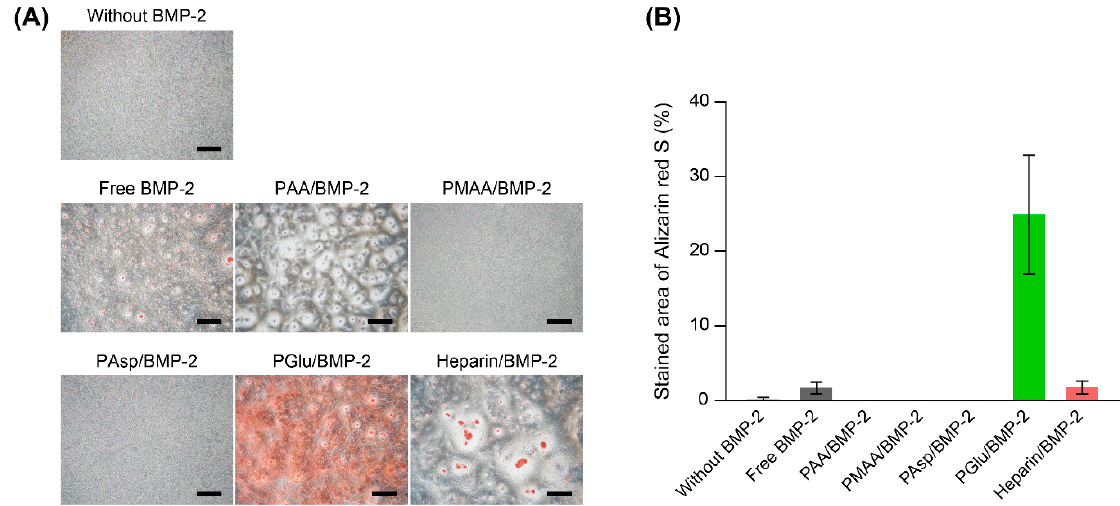
Figure 6. ( A ) Alizarin red S staining of MC3T3-E1 cells treated with free BMP-2, PAA / BMP-2, PMAA / BMP-2, PAsp / BMP-2, PGlu / BMP-2, and heparin / BMP-2 complexes for 14 d (Scale bars: 500 µ m). ( B ) Relative area of MC3T3-E1 cells stained with Alizarin red S (n = 4). The concentrations of BMP-2 and the polymers were 100 ng / mL and 1000 µ g / mL, respectively.